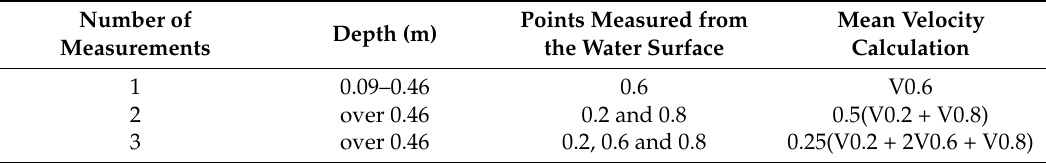
Table 1. Average velocity at various depths for wading measurements